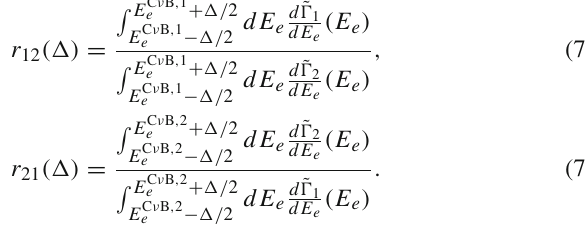
, r C ν B and Dirac and i